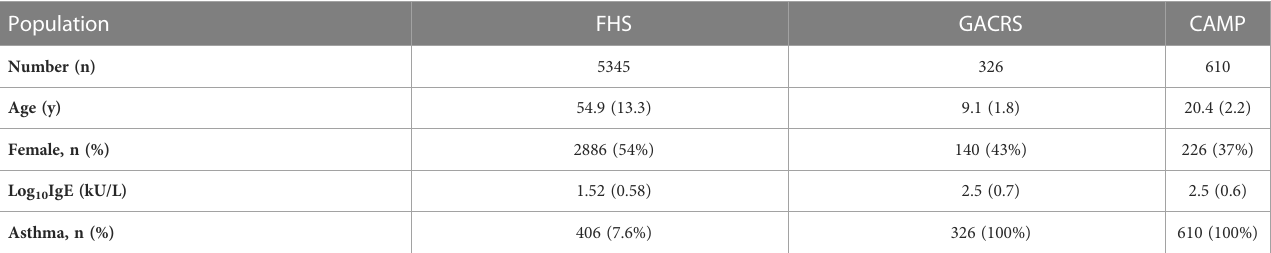
TABLE 1 Participant characteristics of the FHS, GACRS, and CAMP